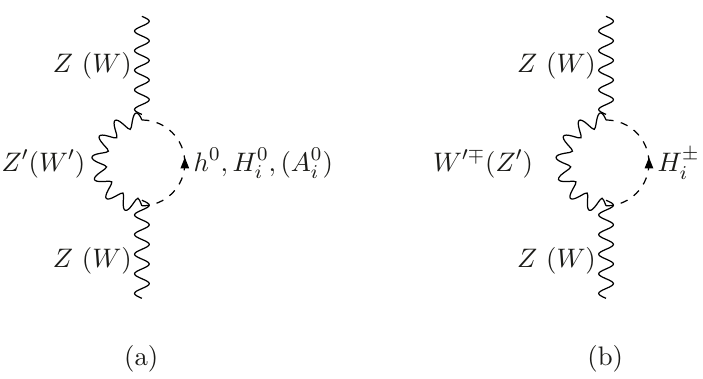
as well as the QED-like